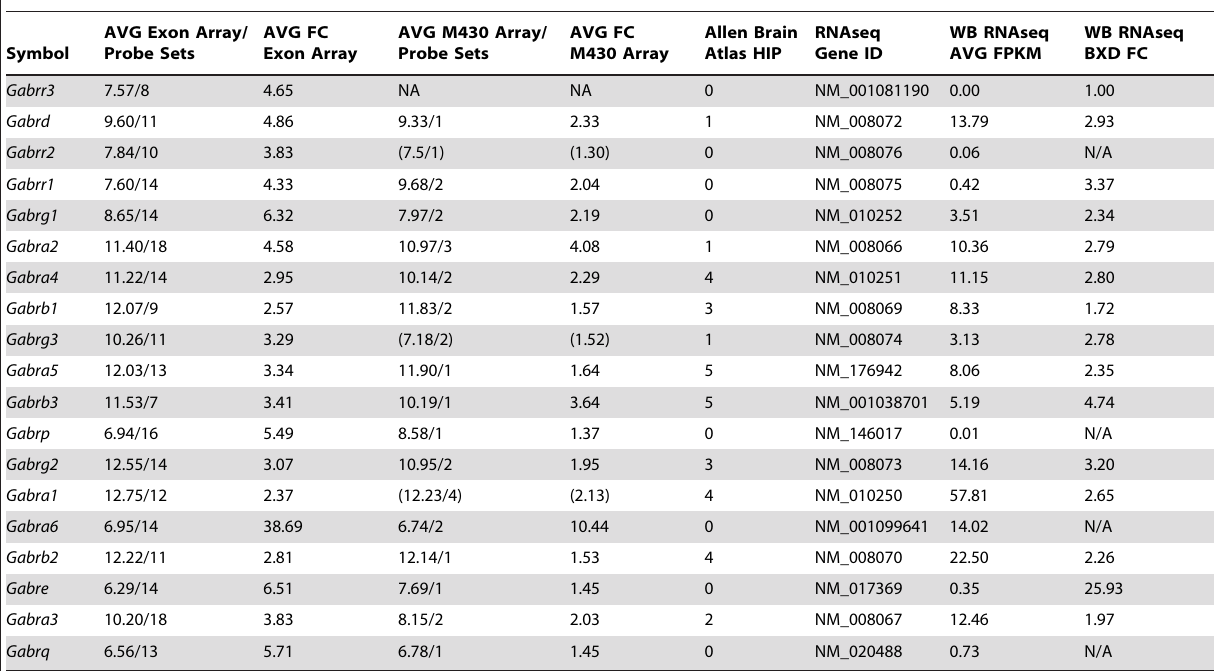
HIP=Hippocampus, AVG=Average log2 standardized expression with a mean of 8 and standard deviation of 2, Exon=Exon array platform, M430=M430 array platform, FC=Fold Change in expression between the highest and lowest strain, ()=Measurement includes probes overlapping SNPs as all probe sets are